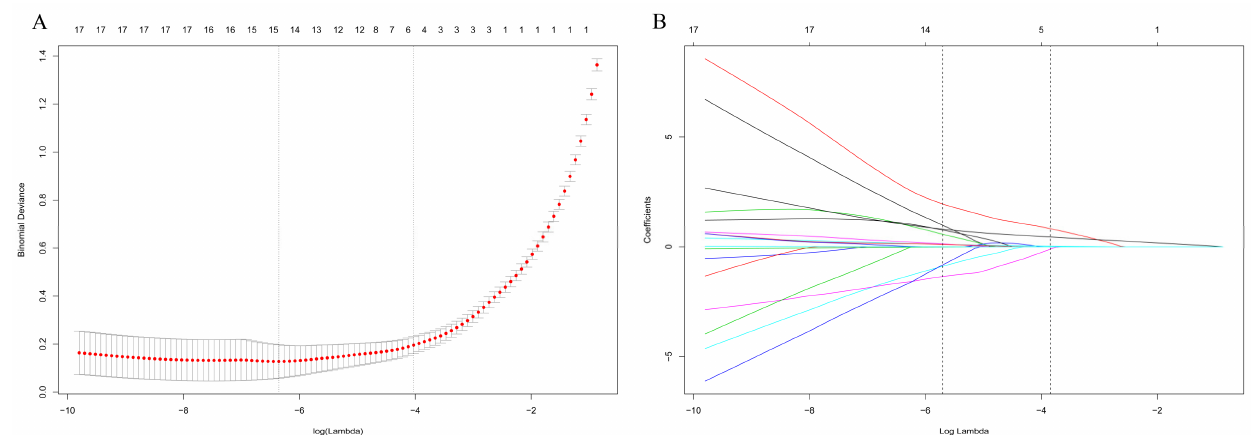
Figure 2. Texture feature selection using the least absolute shrinkage and selection operator (LASSO) binary logistic regression model. ( A ) The Tuning parameter ( λ ) for the LASSO model was selected using ten-fold cross validation via minimum criteria. Dotted vertical lines were drawn at the optimal values in reference to the minimum criteria and one s.e. of the minimum criteria. ( B ) A coefficient profile plot was produced against the log ( λ ) sequence. A vertical line was drawn at the value selected using ten-fold